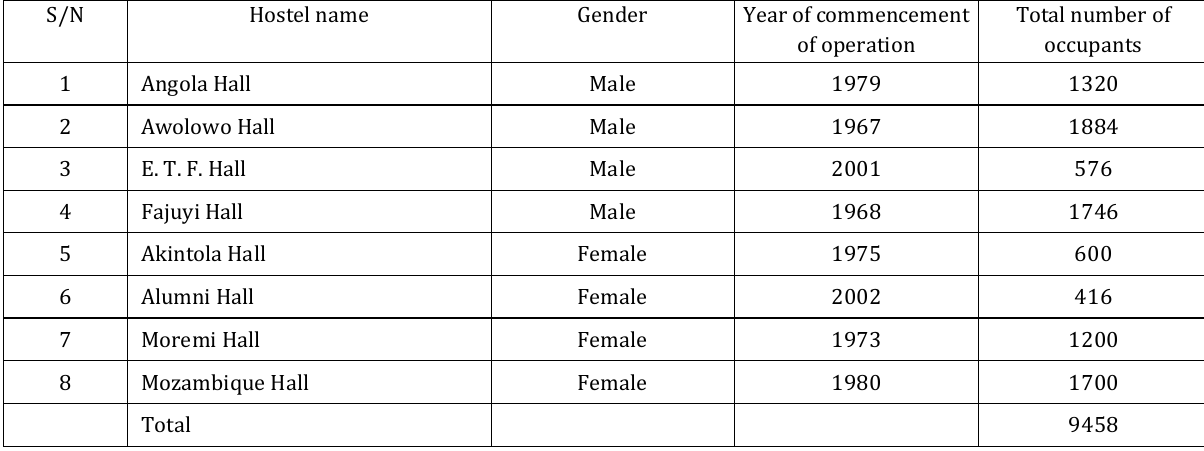
Table 1. Details of student halls on OAU